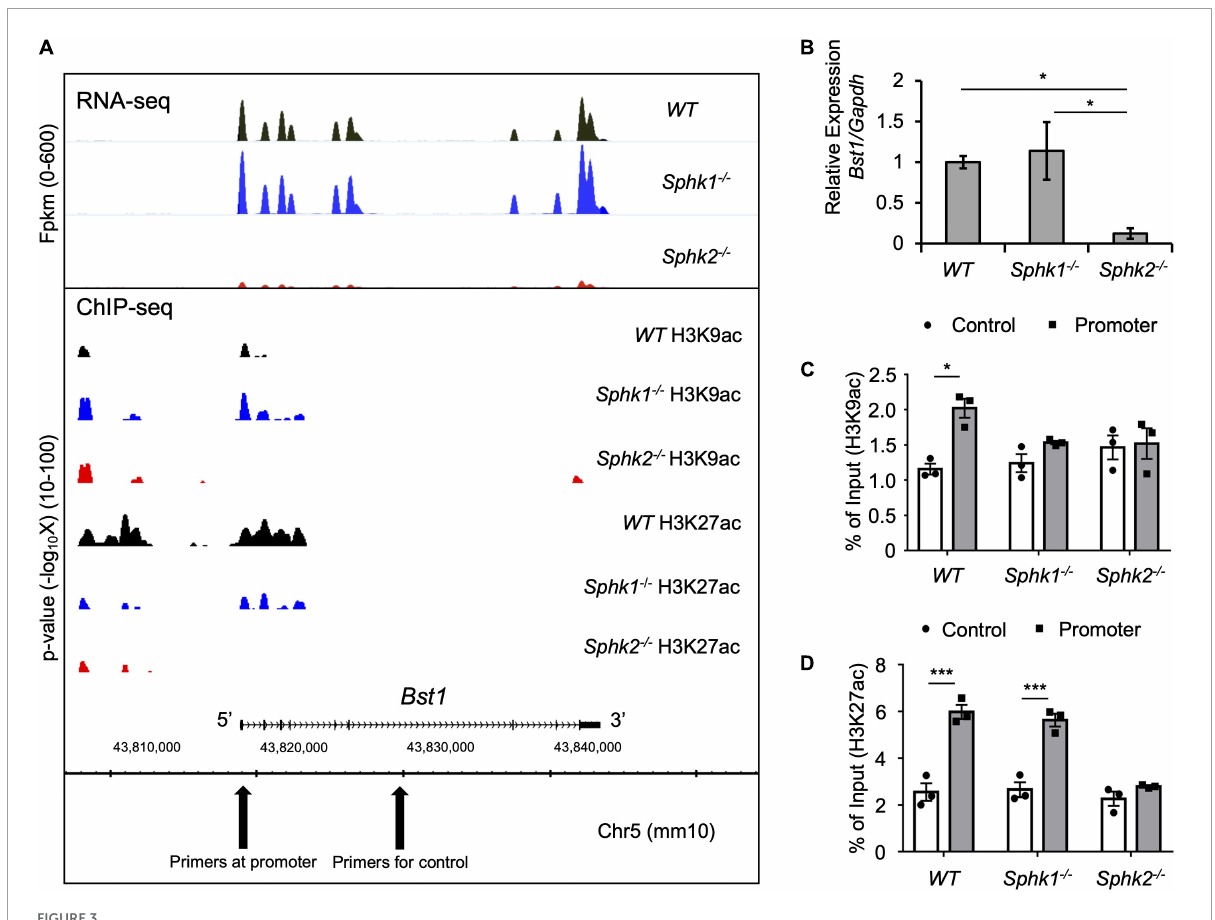
FIGURE3 Genome-wide analysis data around Bst1 gene. (A) RNA-seq and ChIP-seq were performed using RNA or DNA of fibroblasts isolated from kidneys of unoperated WT , Sphk1 − / − and Sphk2 − / − mice and showed suppressed gene transcription (top panel) and histone acetylation around Bst1 gene (bottom panel) in Sphk2 − / − -derived cells. X-axis shows the locus of the genome. Top panel, Bst1 gene expression as Fpkm (fragments per kilobase of exon per million mapped fragments) across the genome including the Bst1 gene. Bottom panel: Localization and magnitude of histone marks on the genome around Bst1 gene. Y axis shows the statistical significance ( p value) of the enrichment level of ChIP signals in the regions comparing to background. (B) Real time PCR of Bst1 confirmed RNA-seq data. ChIP-qPCR (expressed as% of input DNA) of H3K9ac (C) and H3K27ac (D) confirmed ChIP-seq data. n = 4 in panel (B) . n = 3 in panels (C,D) . Data were analyzed using one-way ANOVA in panel (B) and two-way ANOVA in panels (C,D) followed by post hoc multiple-comparison test (Tukey’s). * P < 0.05 and *** P < 0.001.